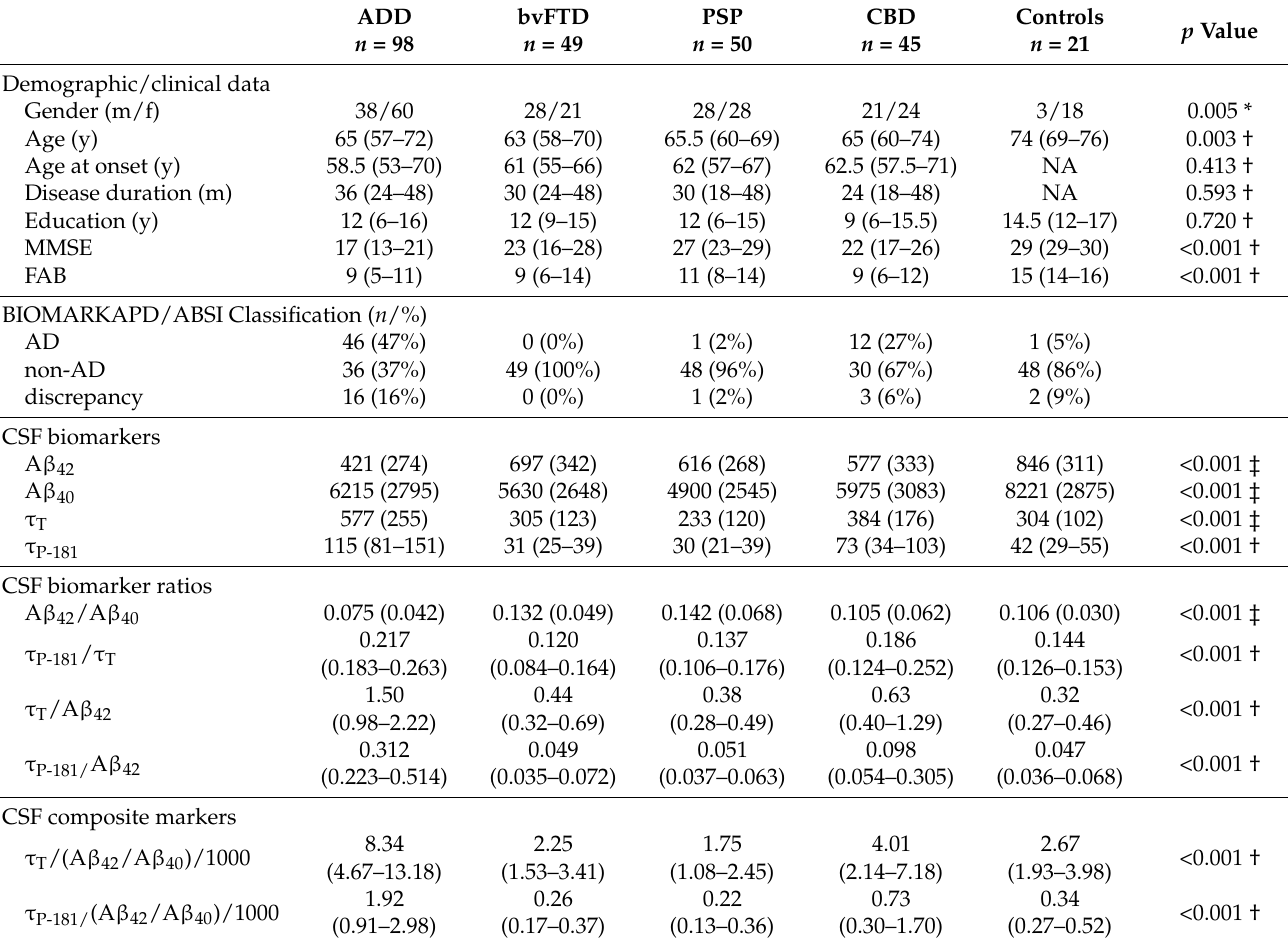
Table 1. Demographic, clinical, and CSF biomarker data. ADD: Alzheimer’s disease dementia; bvFTD: behavioral variant frontotemporal dementia; PSP: progressive supranuclear palsy;